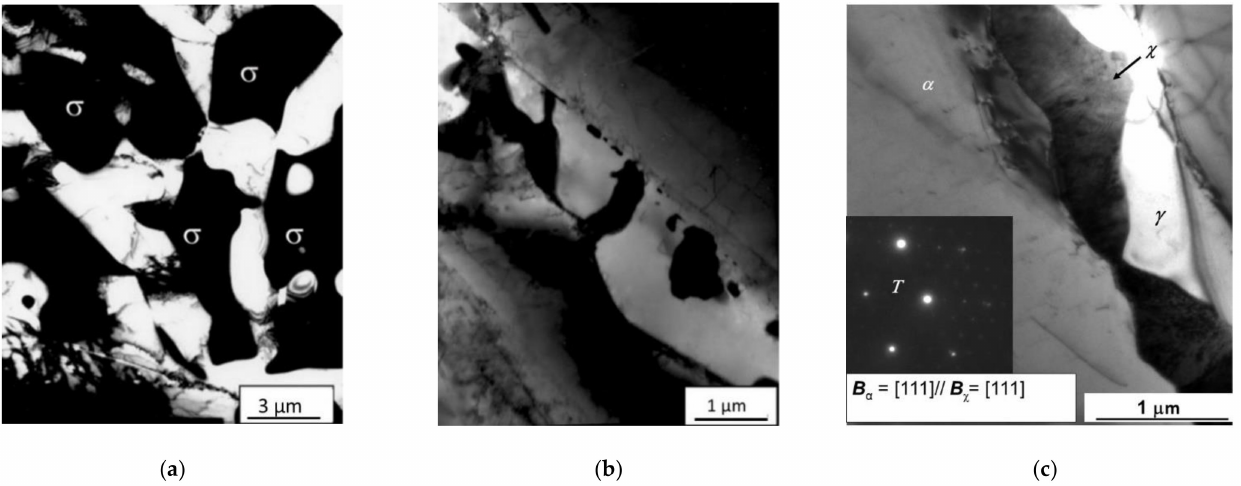
Figure 12. Morphological features of second phases (SPs) in 2205 steel. The σ phase morphology is “oil spot” ( a ) or “coral-like” ( b ) depending on precipitation temperature. The micrograph in ( c ) shows the χ phase and is taken from ref. [54]. From: “Flat-top cylinder indenter examination of duplex stainless steel 2205 after different heat treatments” by G. Angella, A. Fava, R. Montanari, M. Richetta, A. Varone, 2017, Metals